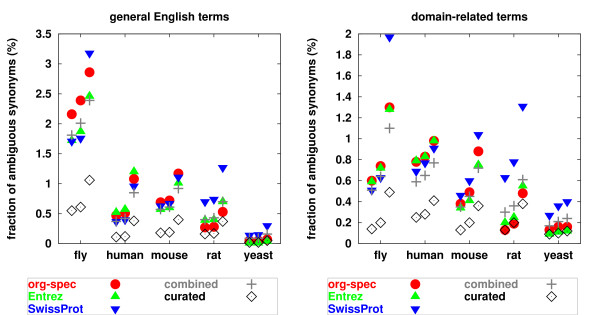
Ambiguity between gene name dictionaries and general English terms and domain-related terms. Ambiguity between gene name dictionaries and general English terms (left plot) and domain-related non-gene and non-protein terms (right plot). Fly shows highest ambiguity with general English terms. All dictionaries show higher ambiguity for normalized gene names than for exact gene names. For notation see Figure 1, for details see section 'Ambiguity with English lexicon and domain-related terms'.